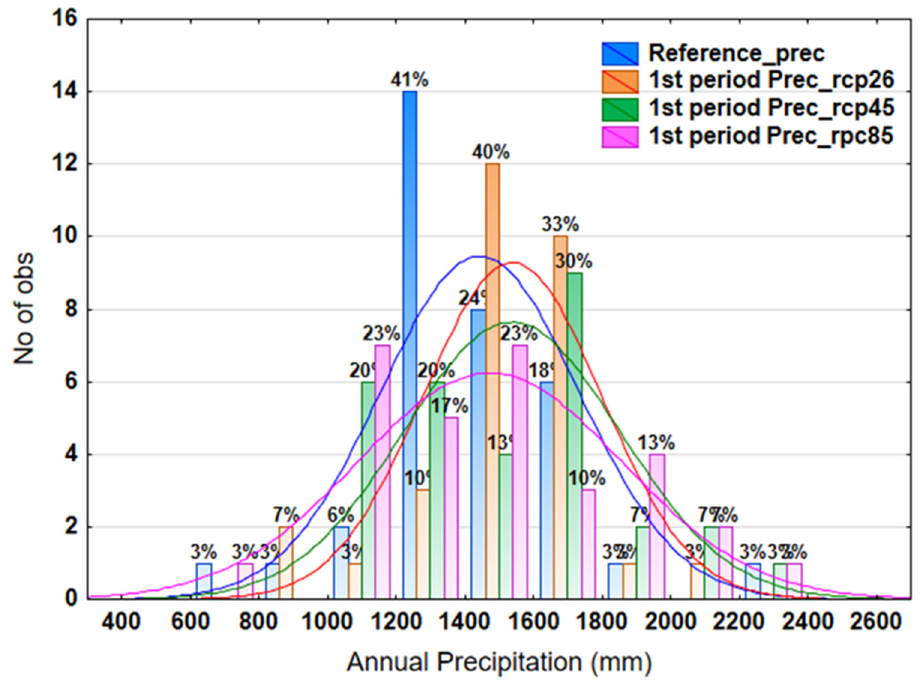
Figure 4. Frequency distribution of annual rainfall for the reference period and the 3 climate scenarios of the first study period (2031–2060).